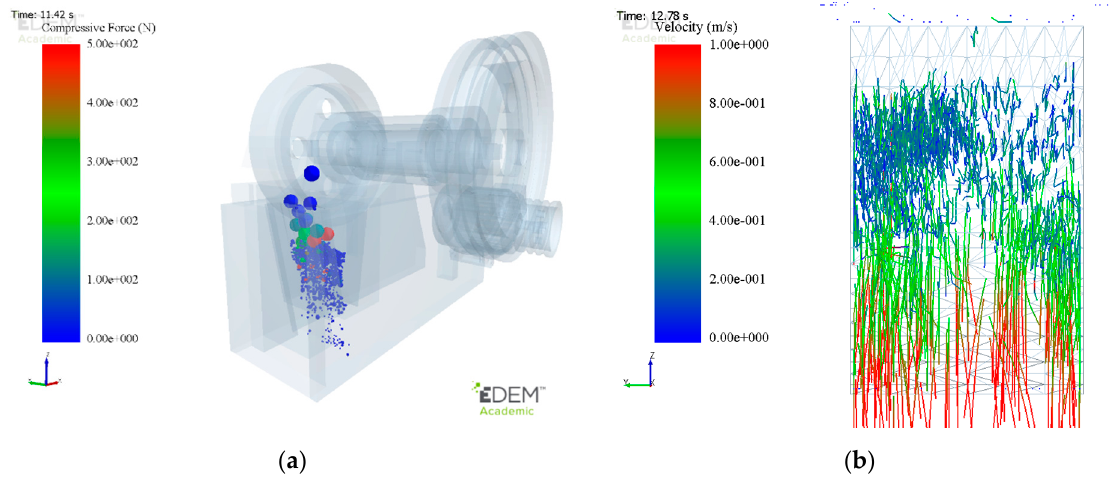
Figure 7. Product size distributions from laboratory jaw crushing tests with different feeds ( a ) and DEM PRM daughter spheres distribution modeled ( b ).